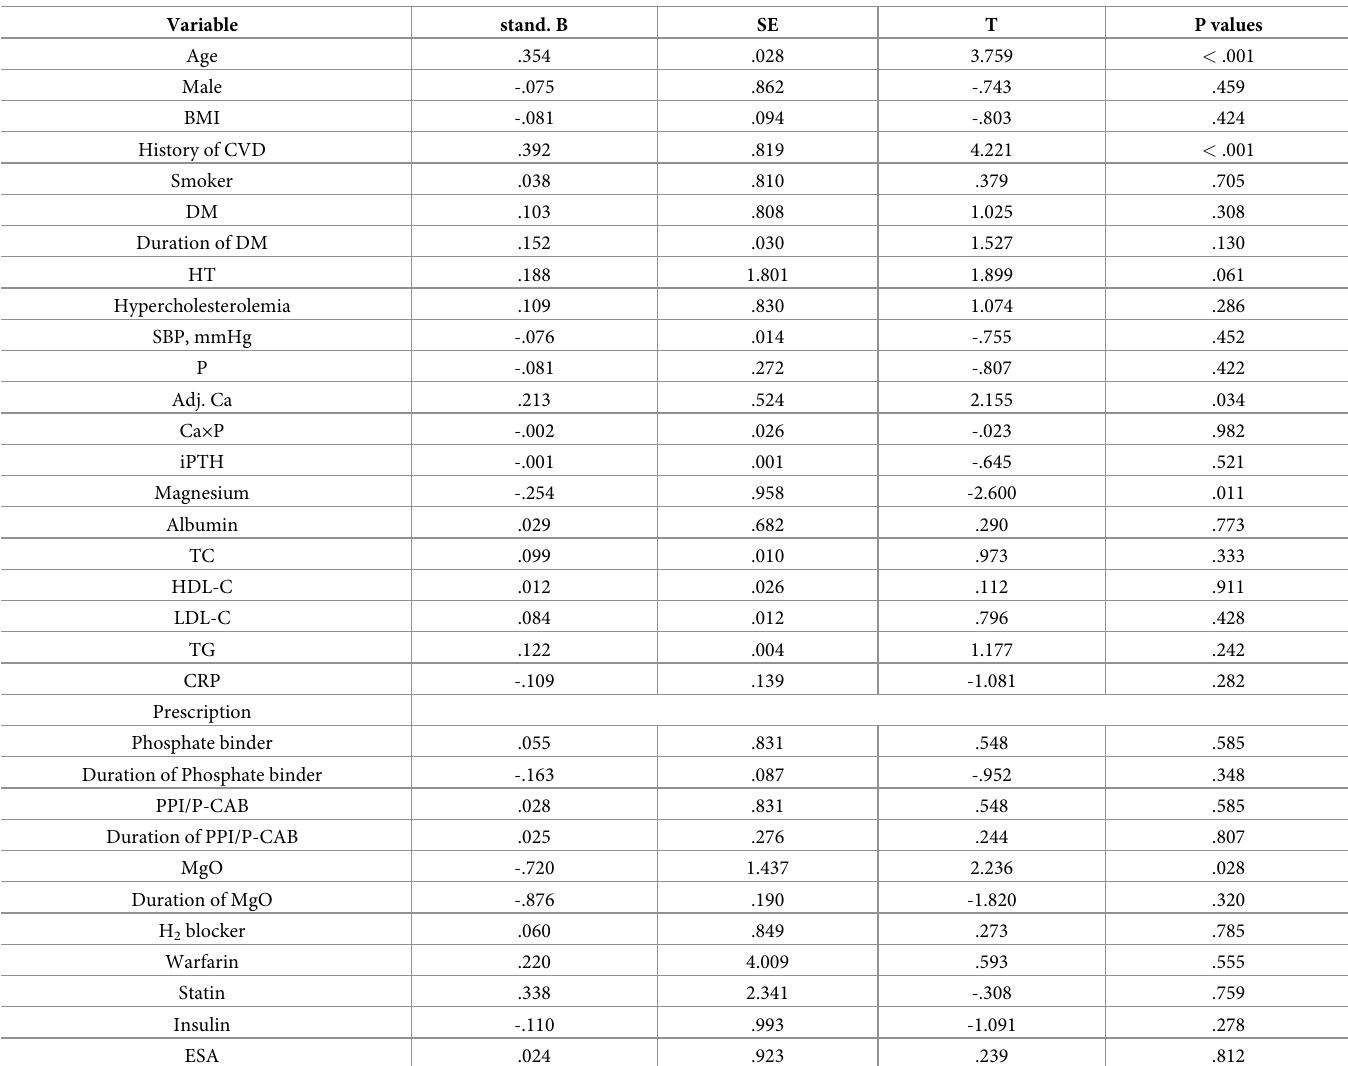
Table 2. Univariate linear regression for AAC volume. Variable stand.